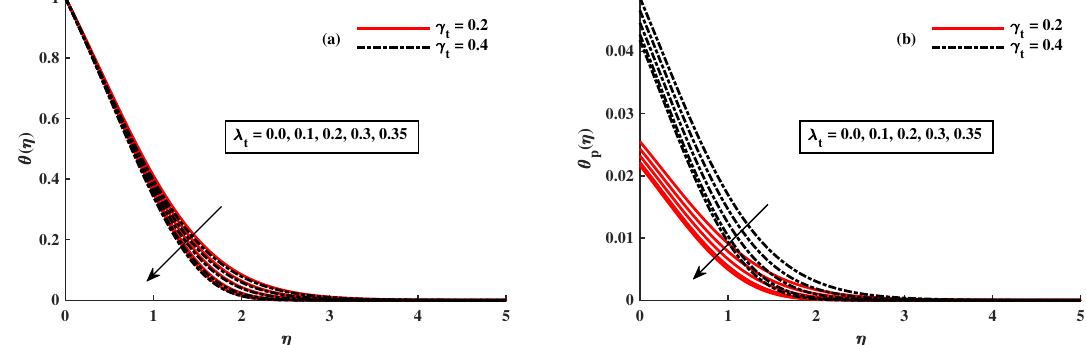
Figure 9. Variation of λ t to influence the fluid and dust temperature profile.